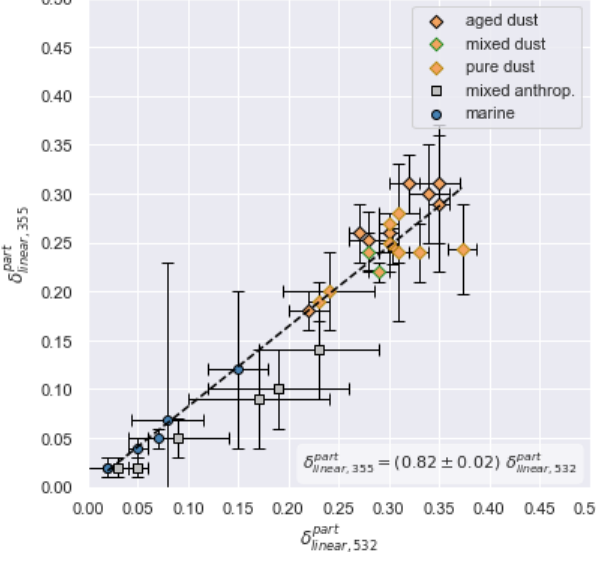
part versus δ part for dust, ma- linear , 355 linear , 532